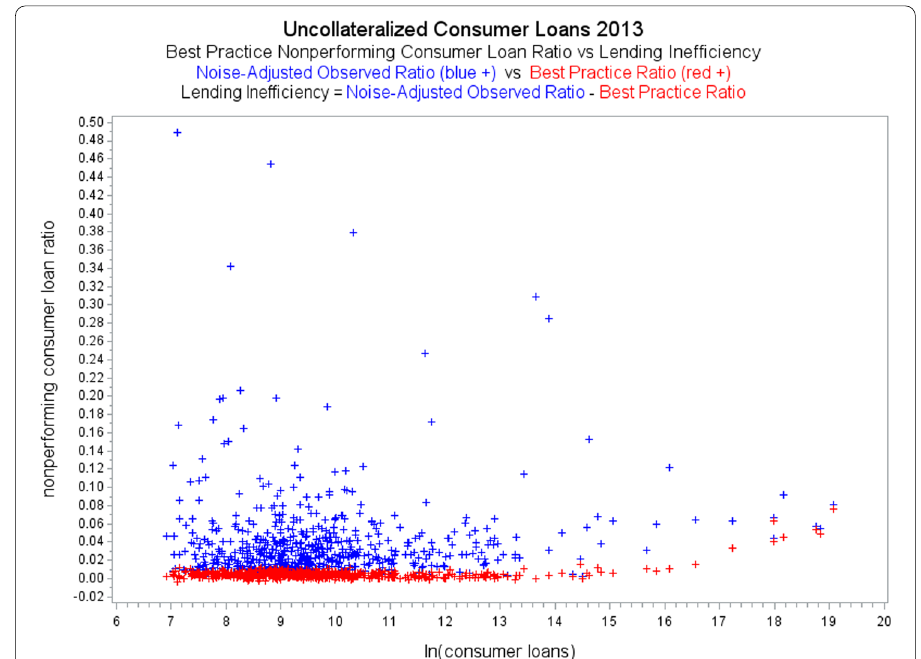
Fig. 5 Nonperforming consumer loan ratio, best practice ratio, and lending inefficiency: 2013, controlling for the loan volume